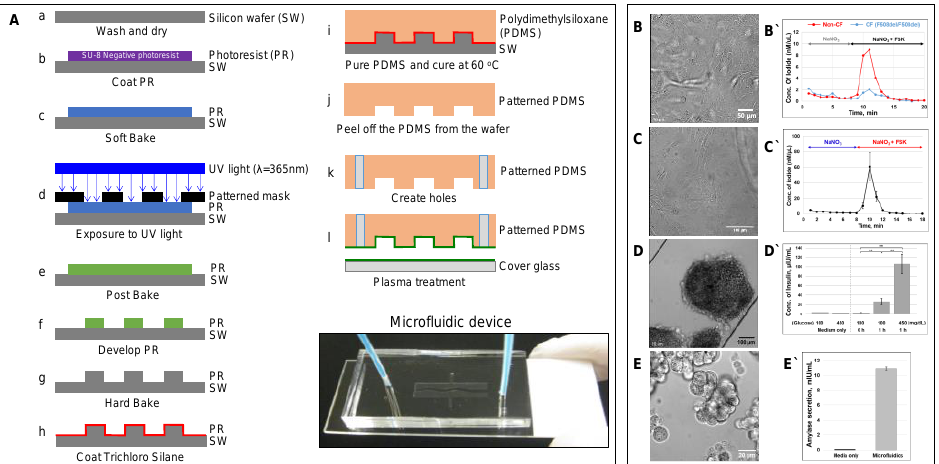
Figure 2. Microfluidic-based organ-on-a-chip. ( A ) Schematic showing a protocol of standardized photolithography and soft lithography techniques to fabricate a microfluidic device [55]. Patient- derived lung airway epithelial cells obtained from CF (F508del/F508del) and non-CF donors ( B ), pancreatic ductal epithelial cells ( C ) [55], aggregated pancreatic islets ( D ) [55], and aggregated acinar cells ( E ) were cultured in microfluidic devices and monitored for CFTR function ( B‘ – C‘ [55]) using an iodide efflux assay. Insulin ( D‘ ) [55] and amylase secretion ( E‘ ) are also shown. To help cell attachment in the channel, the cells were coated with collagen prior to seeding. (ELISA analysis with p-values : ** < 0.005; number of samples: n = 3; Data represented as mean ± SD).